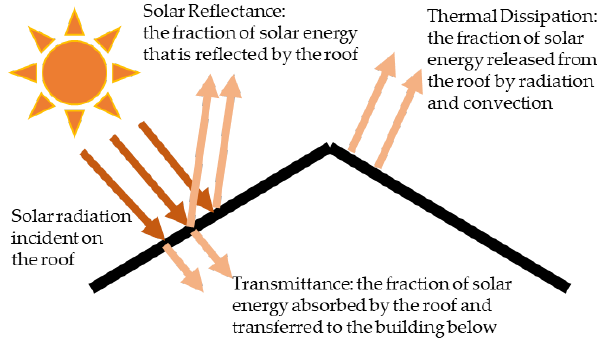
Figure 3. Schematic of roofing surface subject to incident solar energy. Table 3. Categories of cool solutions.